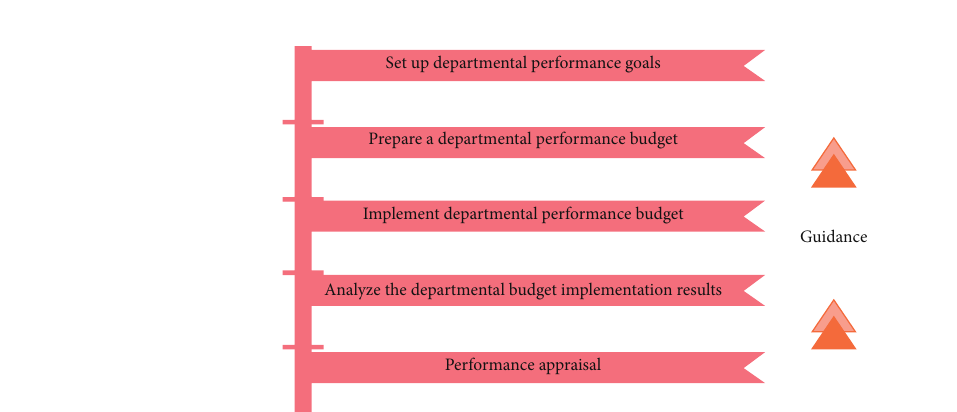
Figure 2: Financial performance analysis system.